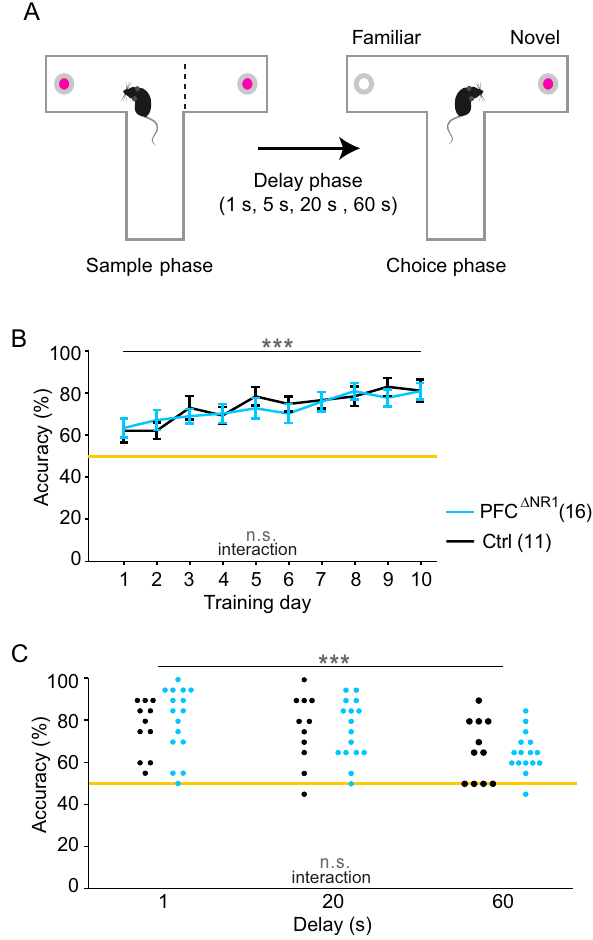
Figure 3. T-maze rewarded alternation assay of DNMTP WM. ( A ) Illustration of T-maze task, in which each trial consists of a rewarded sample phase and a rewarded choice phase, separated by a delay of 5 s during training, or 1 s, 20 s or 60 s during challenges. ( B ) Average alternation performance across the 10 trials of a session over the 10 training days. ( C ) Performance of individual mice (dots, colour-coded as in (B)) in three delay challenges, as indicated. Grey statistical indicators relate to RM-ANOVA, with asterisks on horizontal lines indicating effect of training (B) or delay (C); no significant effect of group was found. The legend indicates the colour-code and size of each group. Orange line, chance level performance. n.s., P > 0.1, *** P < 0.001. Error bars,